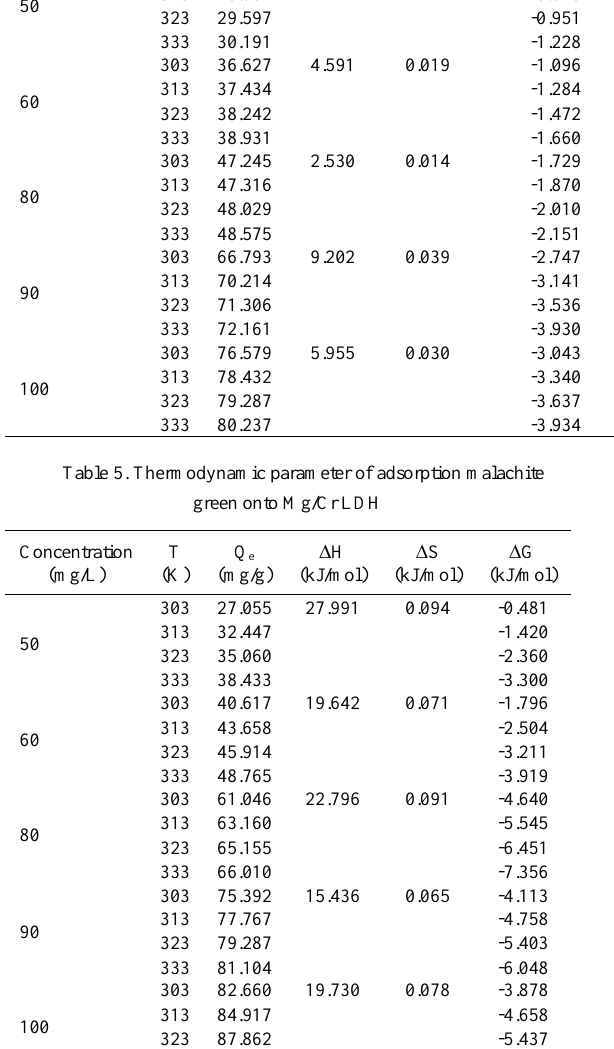
Table 4. Thermodynamic parameter of adsorption malachite green onto Concentration (mg/L)